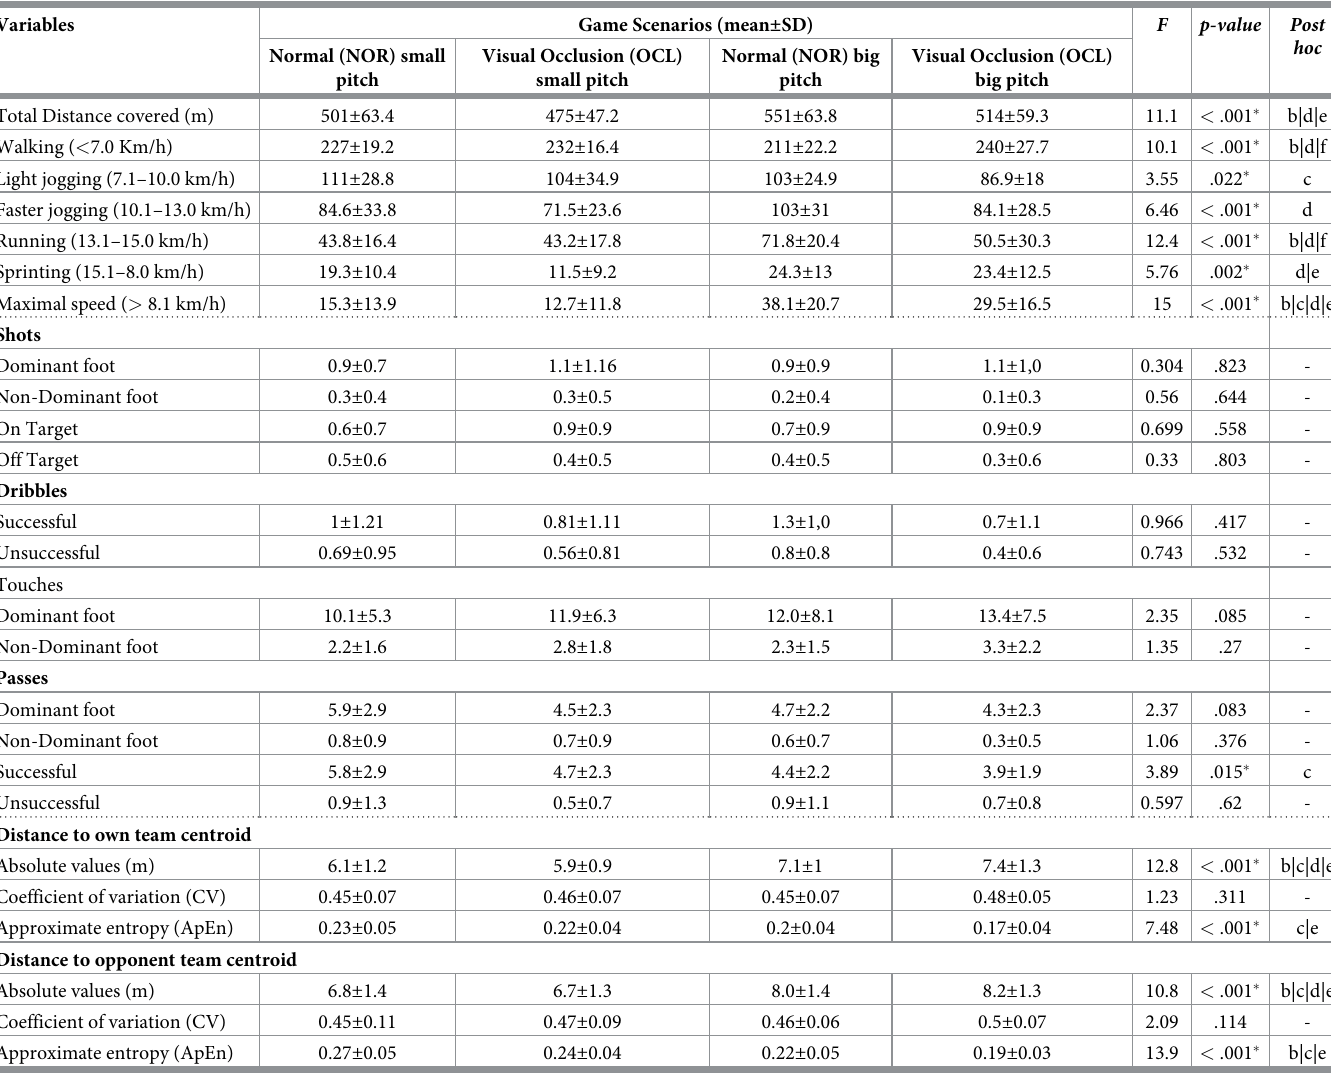
Table 1. Descriptive and inferential analysis of players’ performance measures according to the condition (NOR vs OCL) and pitch size (small vs